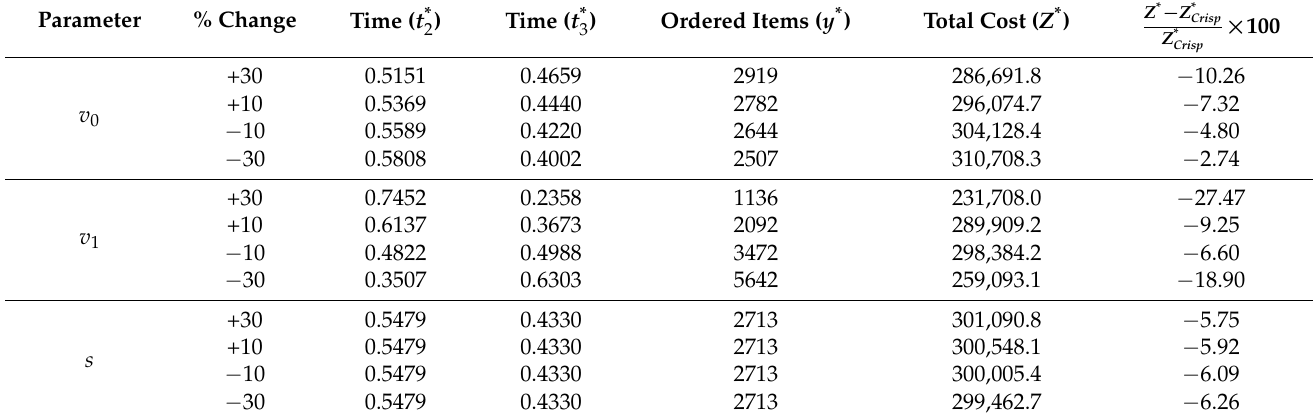
Table 3. Sensitivity analysis of the parabolic dense fuzzy